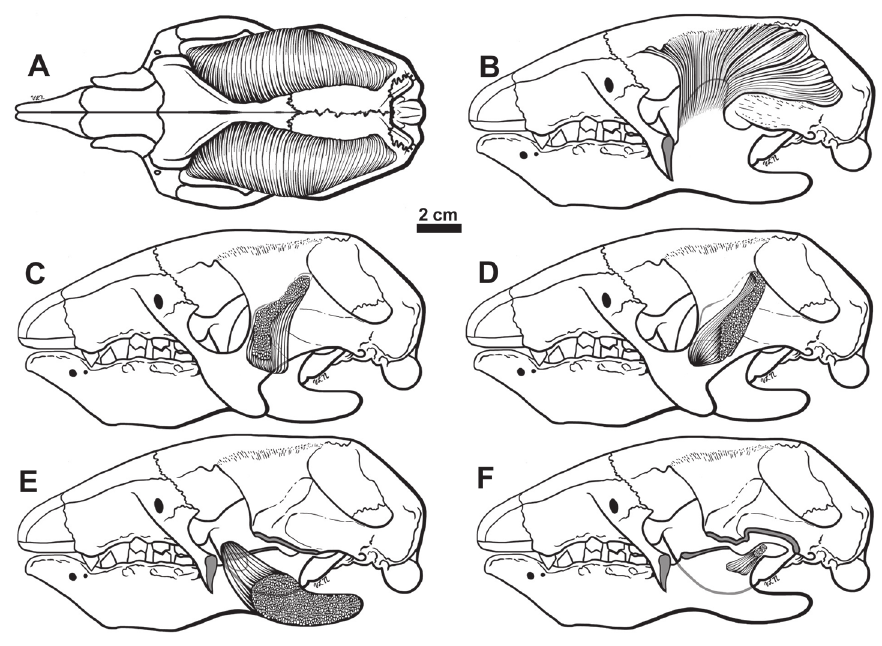
Figure 10. Reconstructions of the M. temporalis in dorsal view ( A ) and lateral view ( B ), the M. masseter profunda ( C ), M. zygomaticomandibularis ( D ), M. pterygoideus medius ( E ) and M. pterygoideus lateralis ( F ). In B the mandibular coronoid process is represented as if the